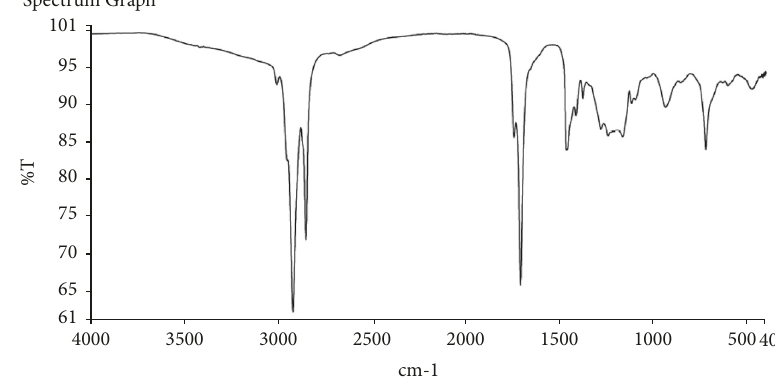
Figure 1: Spectral analysis of Chrysophyllum albidum seed